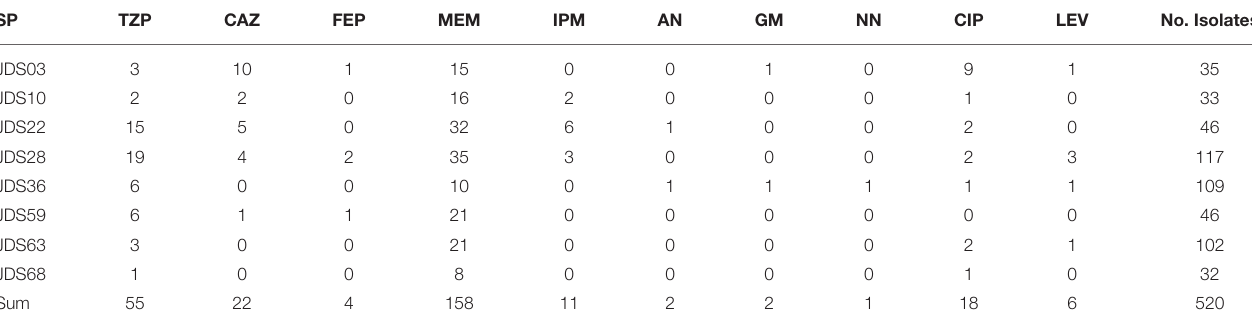
TABLE 3 | Number of isolated Pseudomonas spp. at the investigated sampling points (SP) and the number of resistant isolates to the testes antibioitic. SP